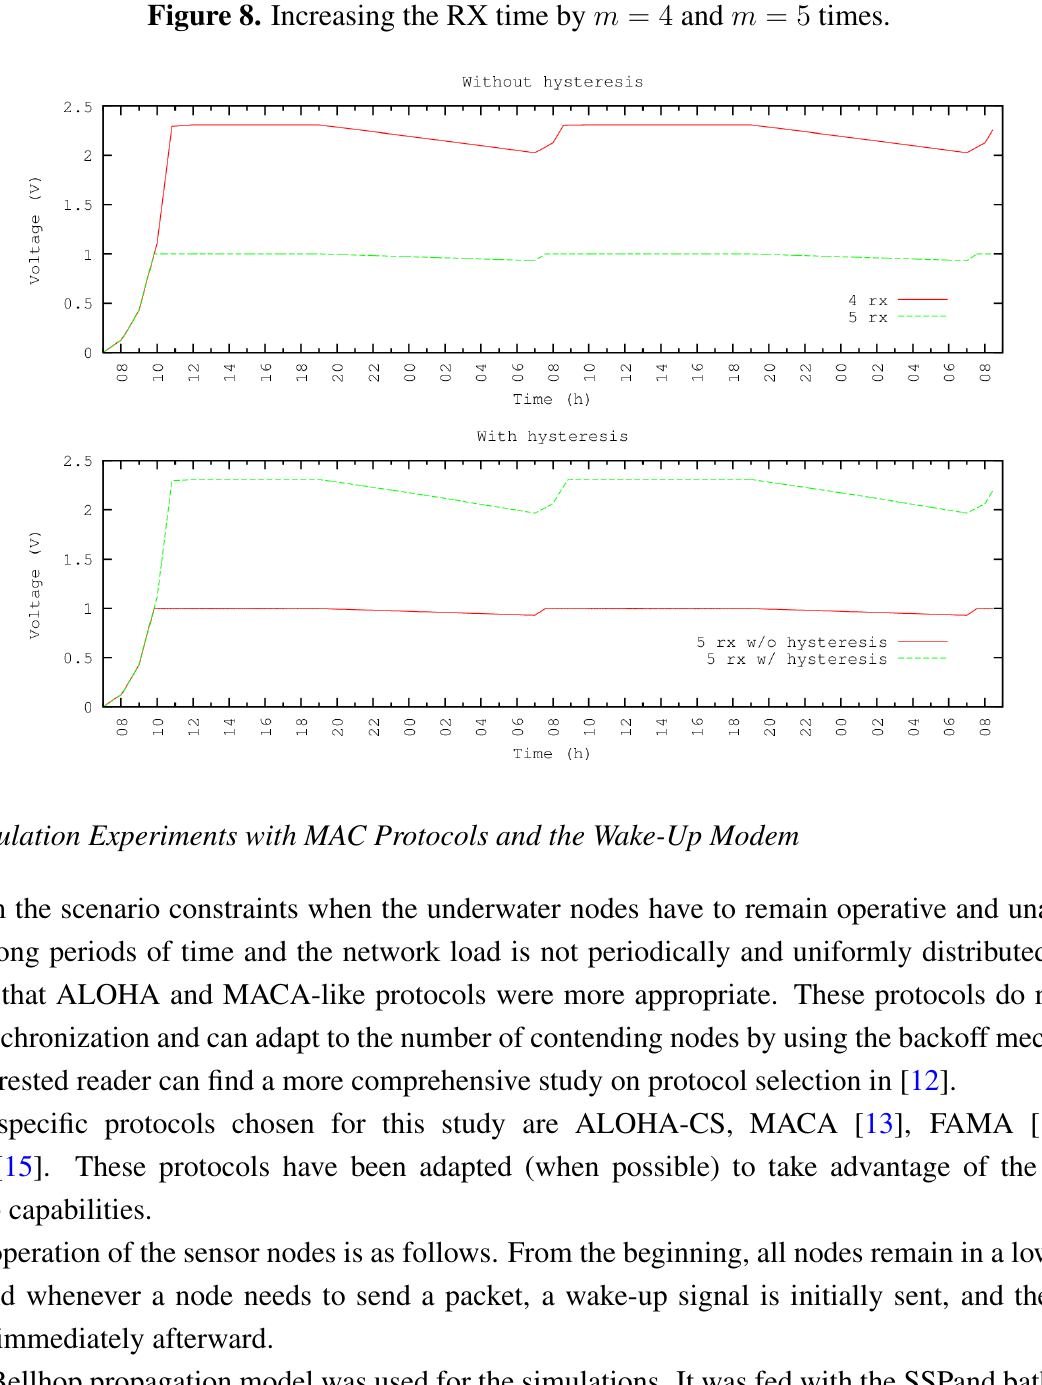
Figure 8. Increasing the RX time by m = 4 and m = 5